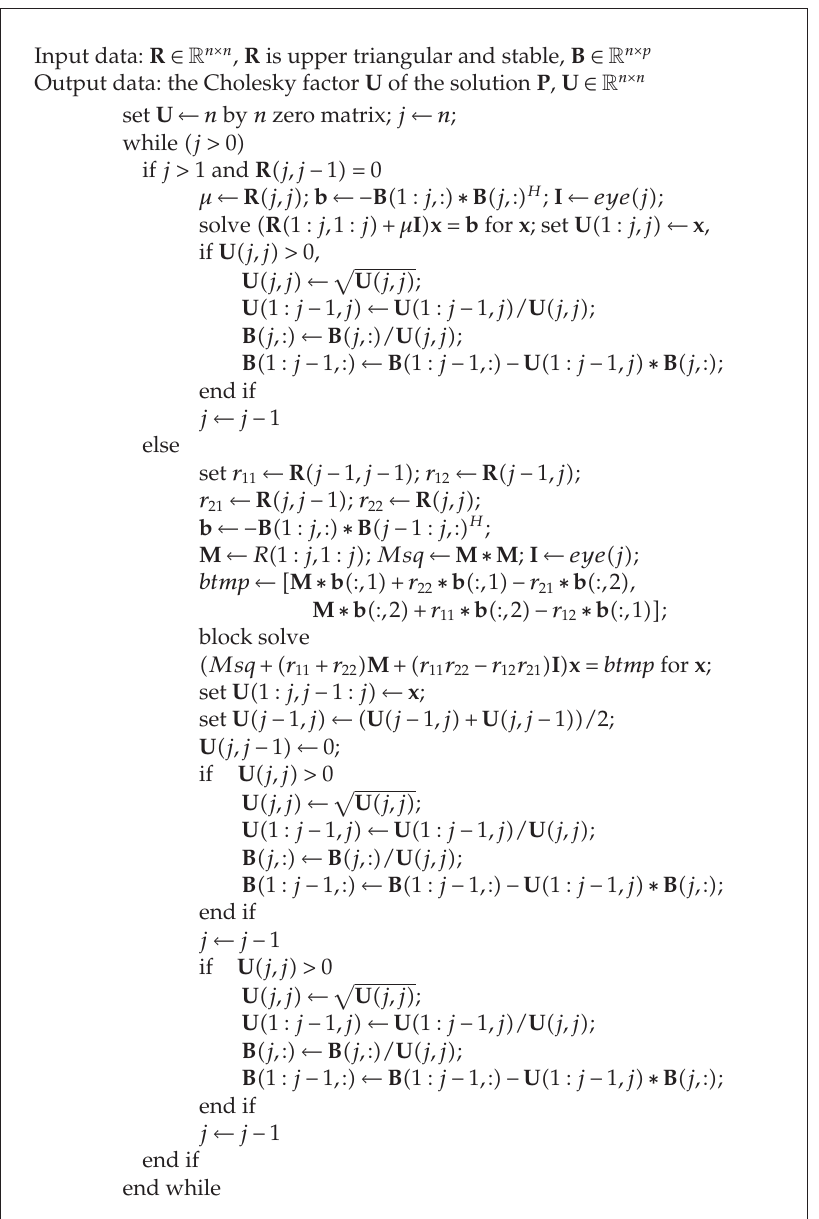
Algorithm 3.2 . Modified Hammarling’s algorithm using